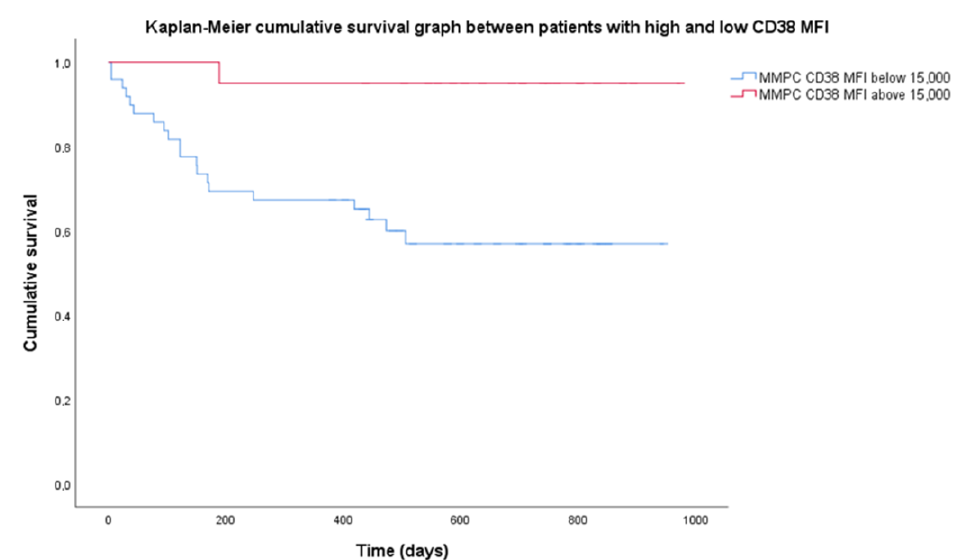
Figure 3. Difference in cumulative survival between subgroups of high and low CD38 expression. High expression of CD38 defined as mean fluorescence intensity (MFI) above 15,000 (20 patients), low—MFI below 15,000 (53 patients). MMPC—malignant plasma cells.